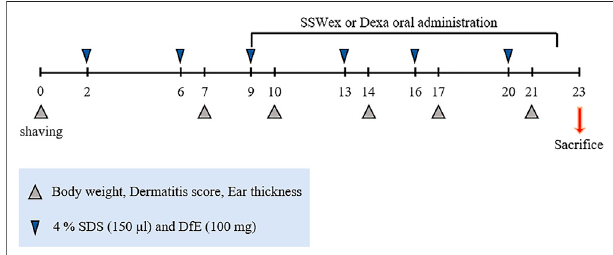
FIGURE 1 | Experimental scheme for the Dermatophagoides farinae extract (DfE) – treated NC/Nga mouse model. The mice were sensitized